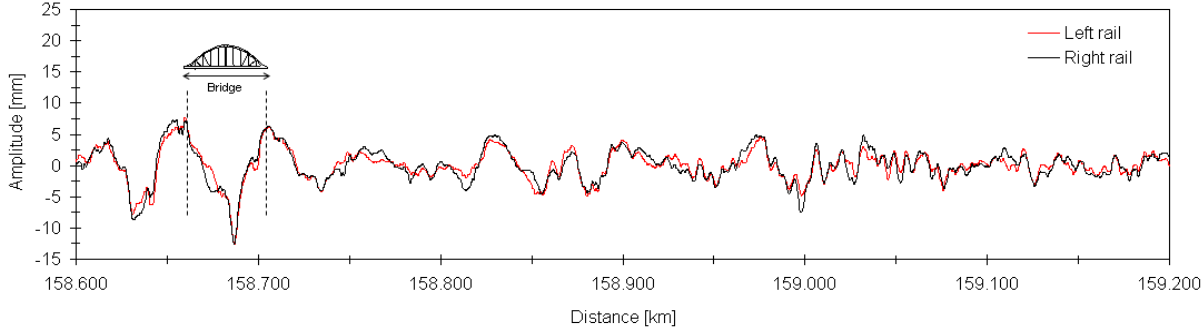
Figure 5. Longitudinal leveling of the left and right rails.